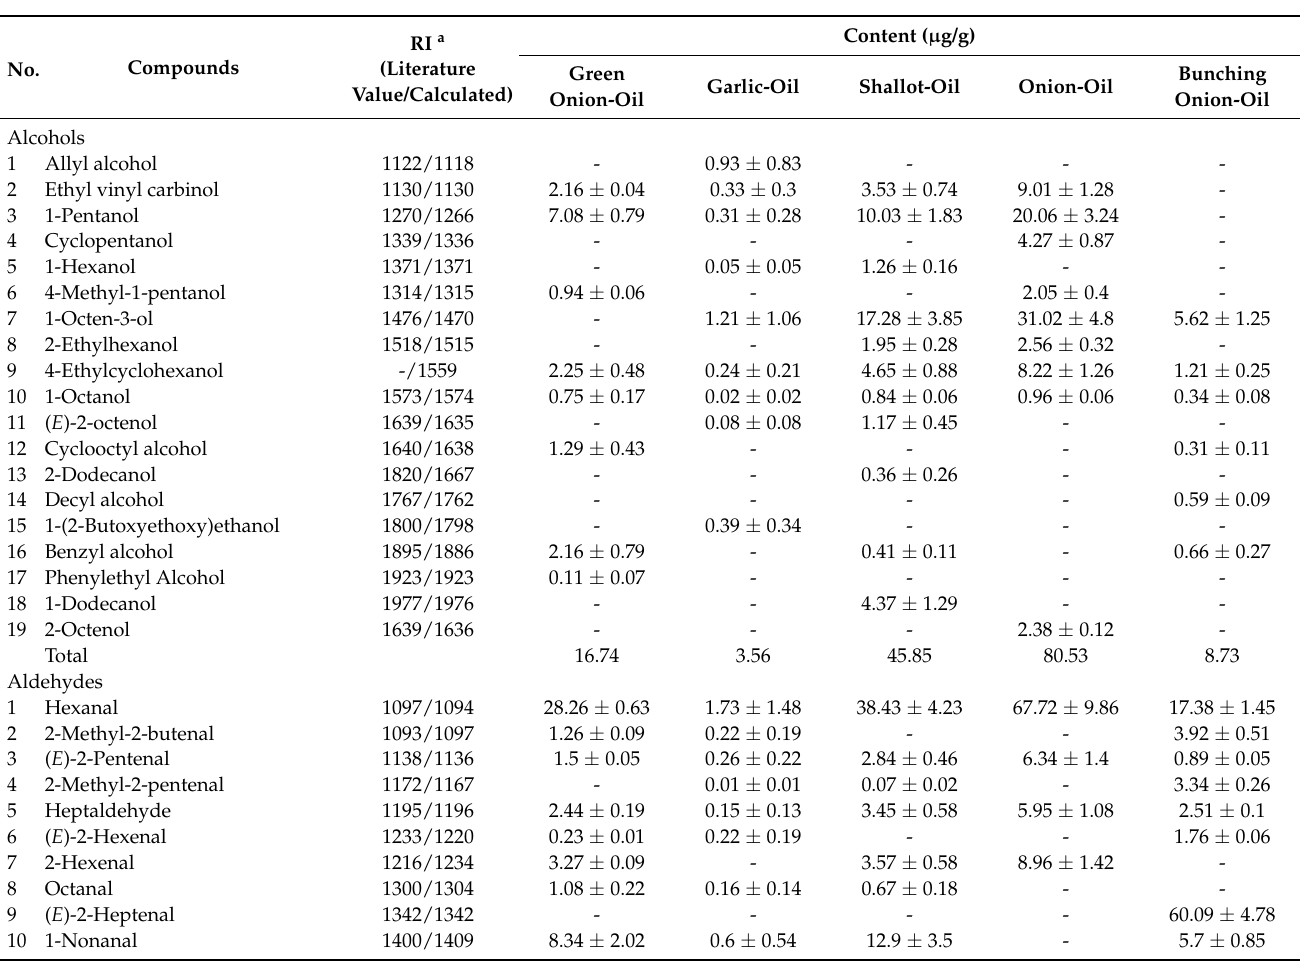
Table A4. Comparative analysis of the volatile compounds detected in five fried Allium oils by